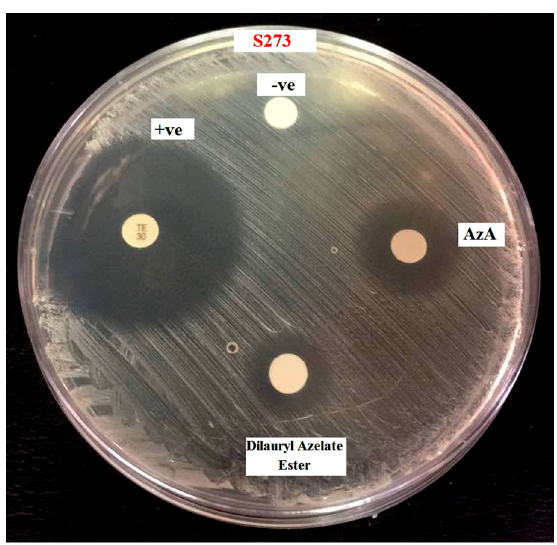
Figure 5. The inhibition zone of AzA and dilaurylazelate ester on bacteria Staphylococcus epidermidis S273 , ( − ve is Acetonitrile and +ve is Standard (Streptomycin)). Table 5. The size of the inhibition zone indicated the antibacterial effect of AzA and dilaurylazelate ester on bacteria Staphylococcus epidermidis S273.